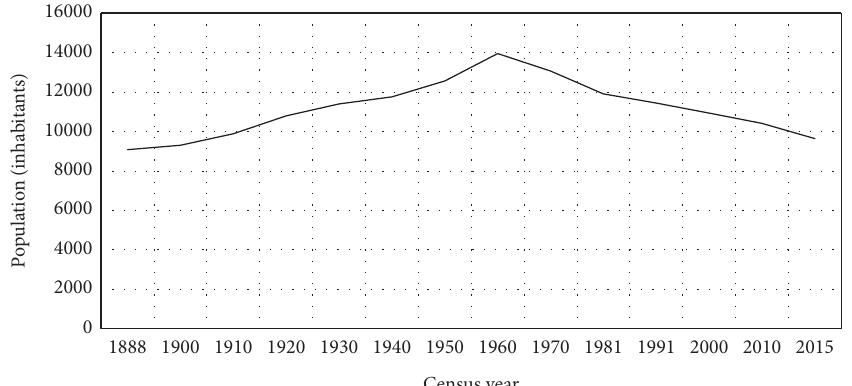
Figure 4: Population in the study area between 1888 and 2015.